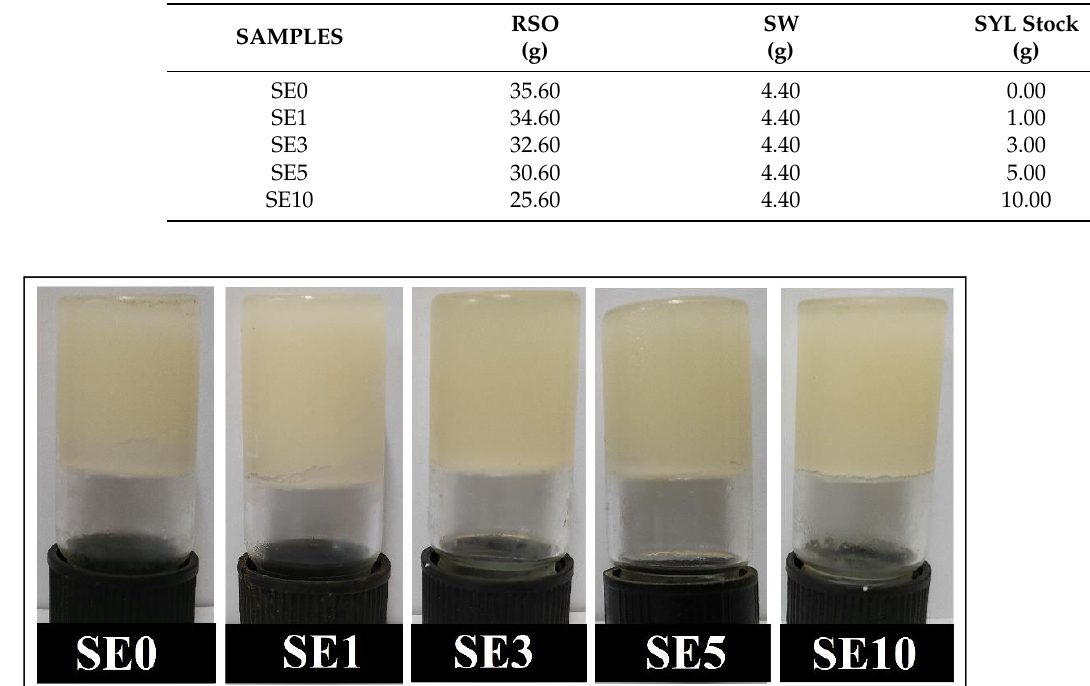
Figure 1. Image of representation of the prepared oleogels.